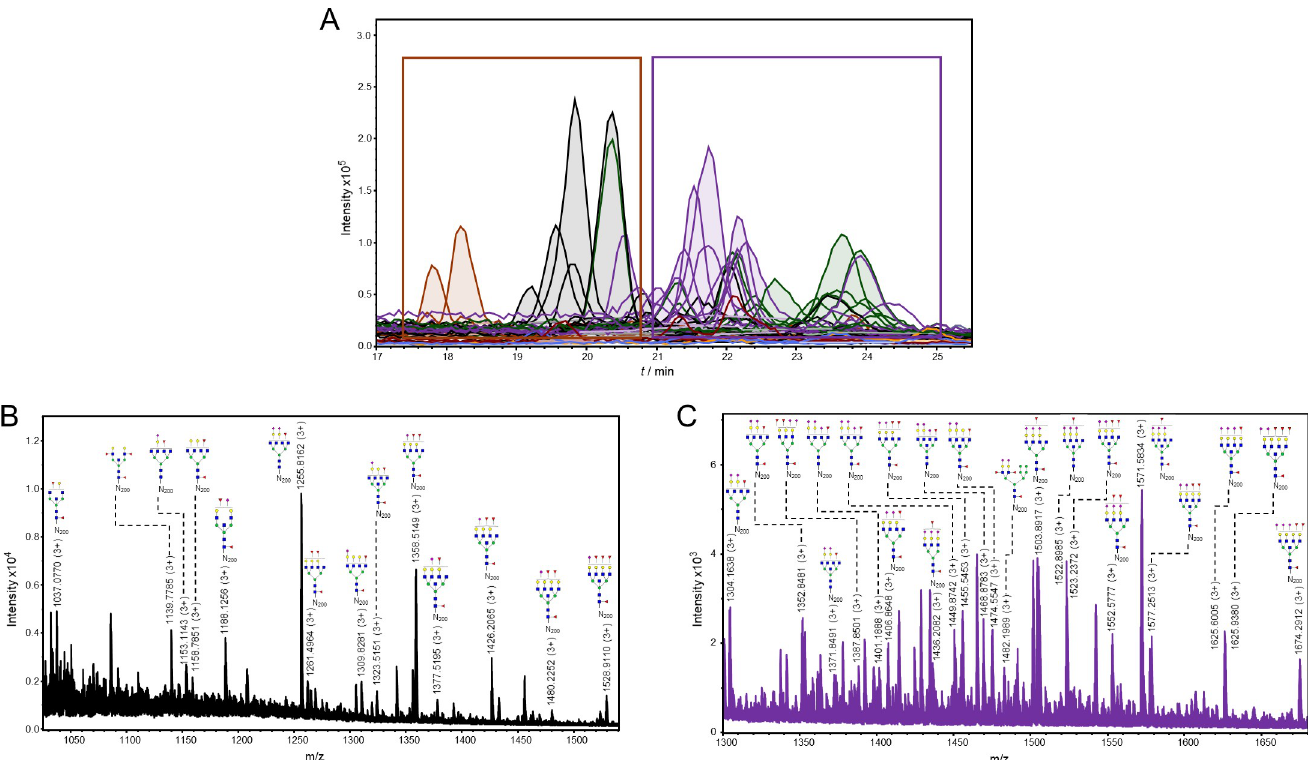
Fig 7. Representation of detected glycoforms on the N-200 glycosylation site of 21K slow prion strain. A) Extracted ion chromatograms with mutual 35 glycoforms detected. B) Assigned glycoforms in MS spectrum with N-200 peptide backbone: neutral and monosialylated, C) disialylated and trisialylated glycoforms. Blue square– N -acetylglucosamine (GlcNAc), green circle–mannose (Man), red triangle–fucose (Fuc), yellow circle–galactose (Gal), purple diamond– N - acetylneuraminic acid (Neu5Ac).